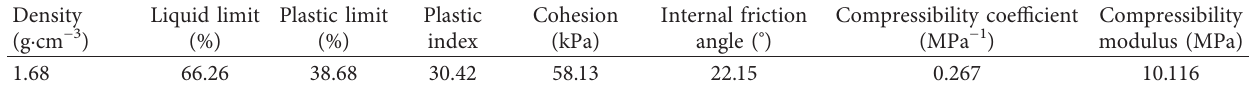
Table 1: Physical and mechanical properties of soil.